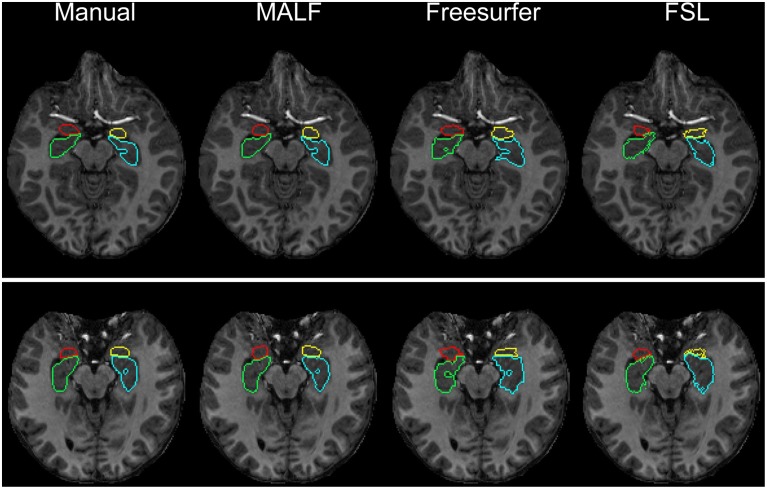
The top and bottom panels show the segmentation results of the left amygdala (yellow), the right amygdala (red), the left hippocampus (blue), and the right hippocampus (green) in individual subjects from the pediatric dataset, different for each panel. From left to right, segmentations are obtained from manual delineation, MALF, Freesurfer, and FSL.